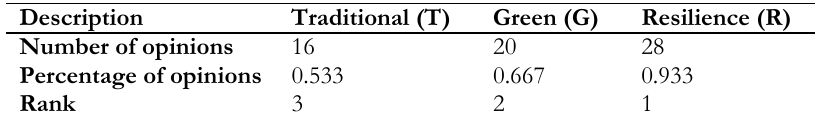
Table 19. Percentage of opinions and rank of each